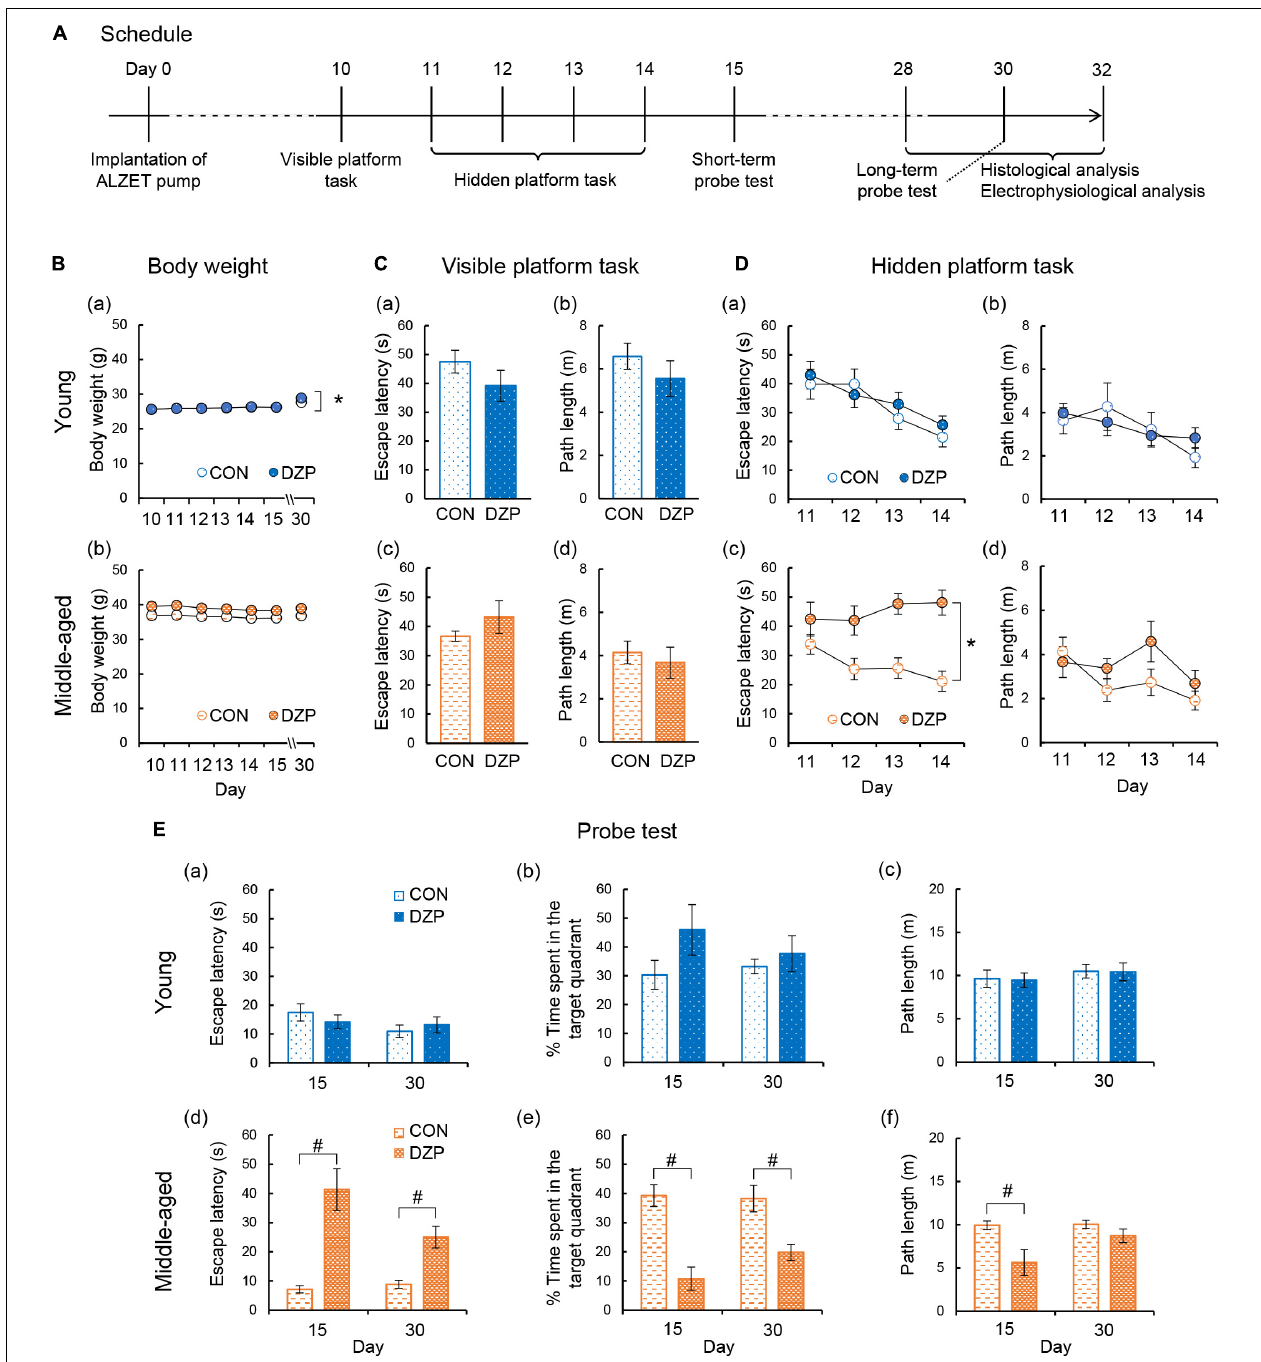
FIGURE 1 | Effects of chronic diazepam administration on spatial memory performance. (A) The schedule of this research including Morris water maze, electrophysiological recordings, and histological analysis. (B) Changes in the body weight during the Morris water maze period. (C–E) Results of the Morris water maze test. (C) Escape latency and path length in the visible platform task of young and middle-aged mice. (D) Escape latency and path length in the hidden platform task from days 11 to 14. (E) Latency to the target quadrant, time spent in the target quadrant, and path length in the probe test on days 15 (short-term) and 30 (long-term). The number of mice that were analyzed in the tasks and probe test was as follows: young CON, n = 7; young DZP, n = 7; middle-aged CON, n = 8; middle-aged DZP, n = 7. Error bar: mean ± SEM. * P < 0.05, two-way analysis of variance with repeated measures. # P < 0.05, t -test. CON, control group; DZP, diazepam